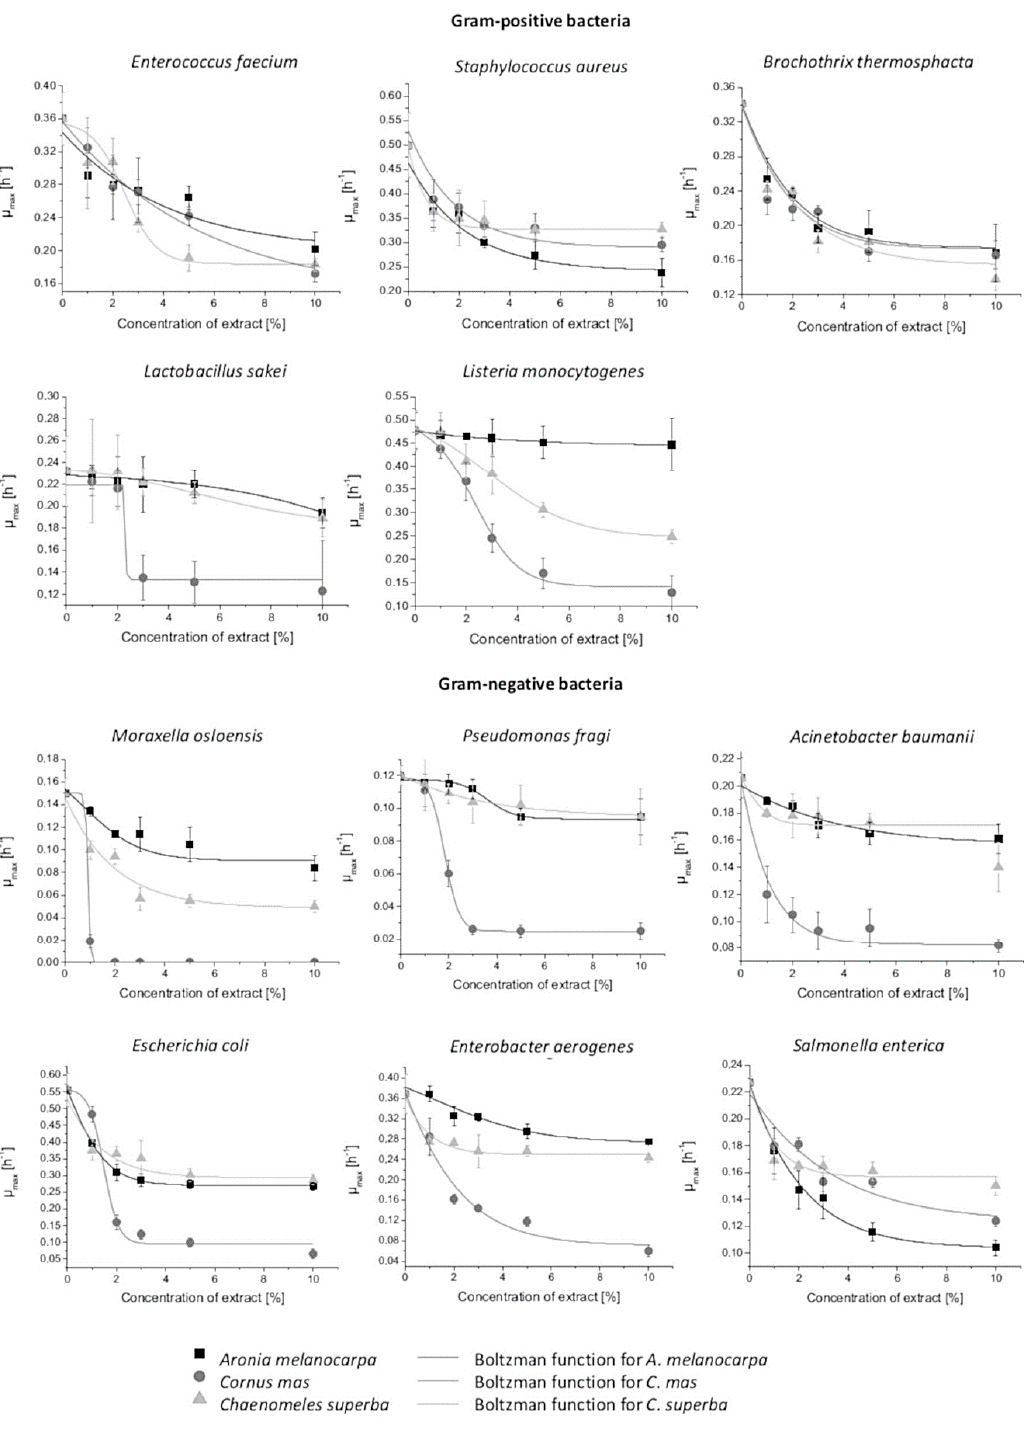
Figure 1. Effect of leaf extracts on bacterial growth rates (µ max ). The results are expressed as mean ±